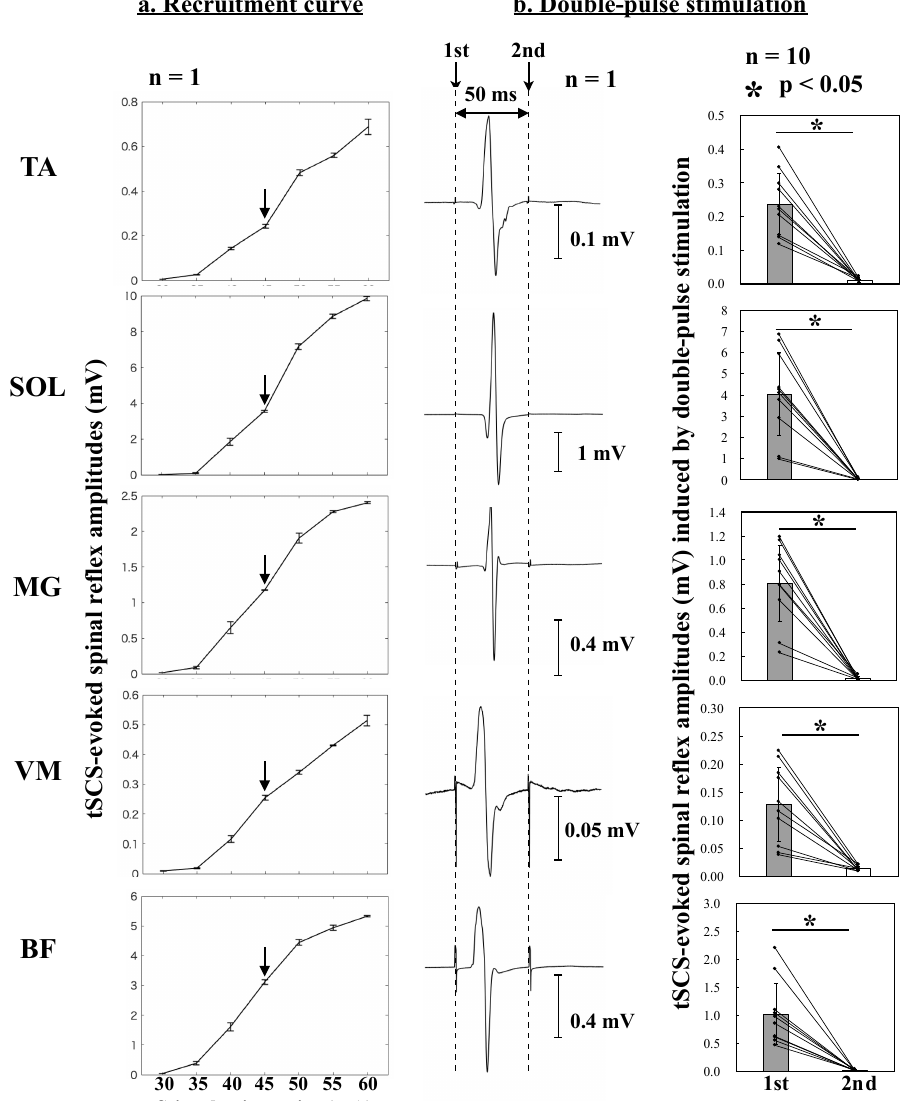
Figure 2. Recruitment curve and double-pulse stimulation. ( a ) Typical recruitment curve recordings of transcutaneous spinal cord stimulation (tSCS)-evoked spinal reflexes obtained in a single participant. Arrows indicate the stimulus intensity on the ascending limbs of each recruitment curve. This intensity was used in subsequent experiments to measure tSCS-evoked spinal reflexes in all muscles. ( b ) Representative examples (left) of averaged tSCS-evoked spinal reflex responses to the first and second stimulations obtained in a single participant. Average tSCS-evoked spinal reflex amplitudes (right, n = 10) of the responses to the first (grey bar) and second stimulations (white bar). Error bars represent standard errors of measurement. Each circle represents an individual data point. * Significant difference between the first and the second response ( p < 0.05, effect size d > 1).